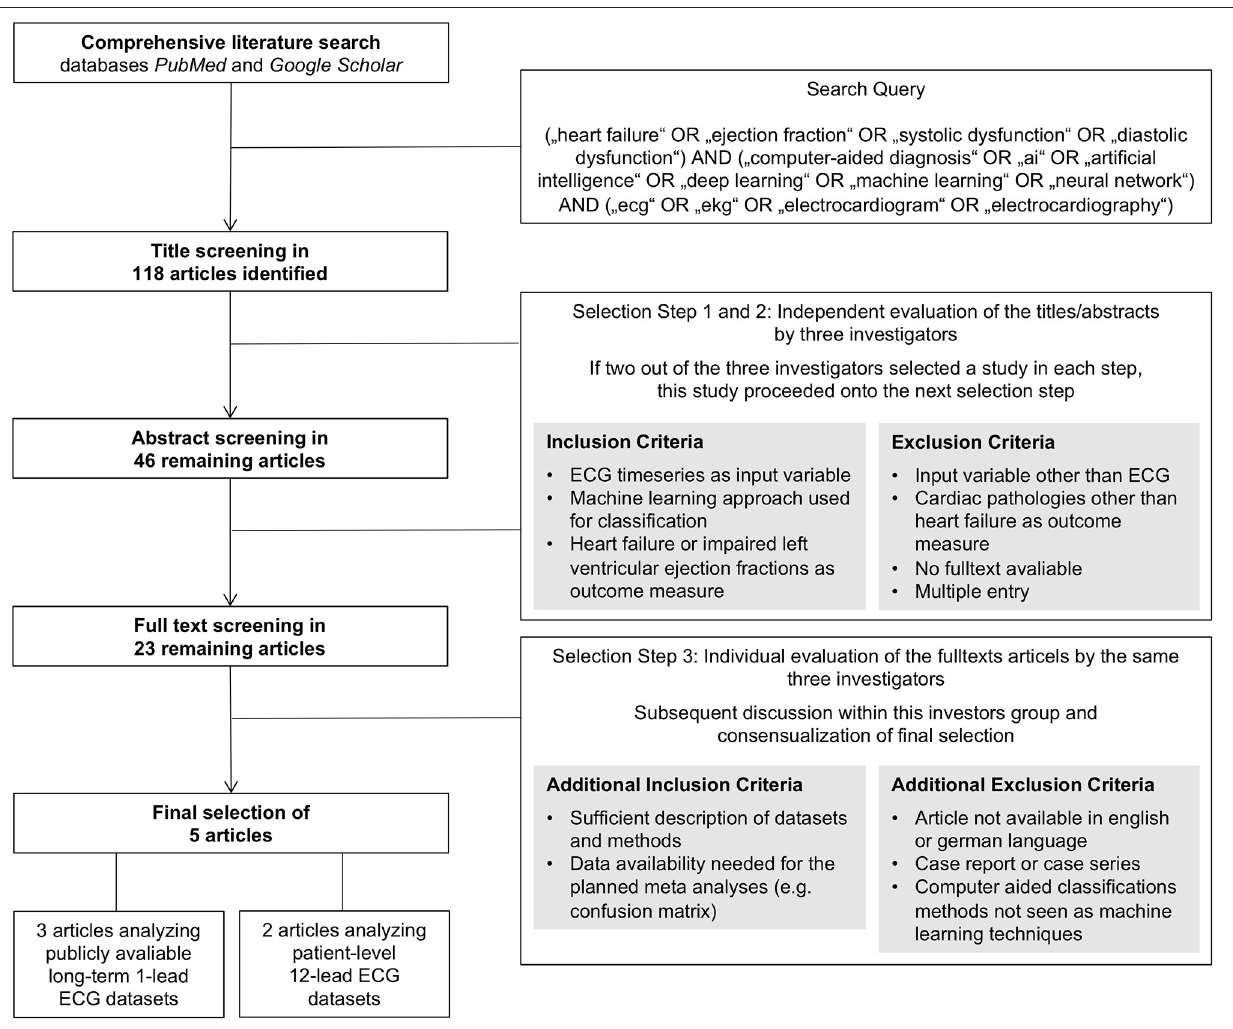
available echocardiographic data with the endpoint LVEF ≤